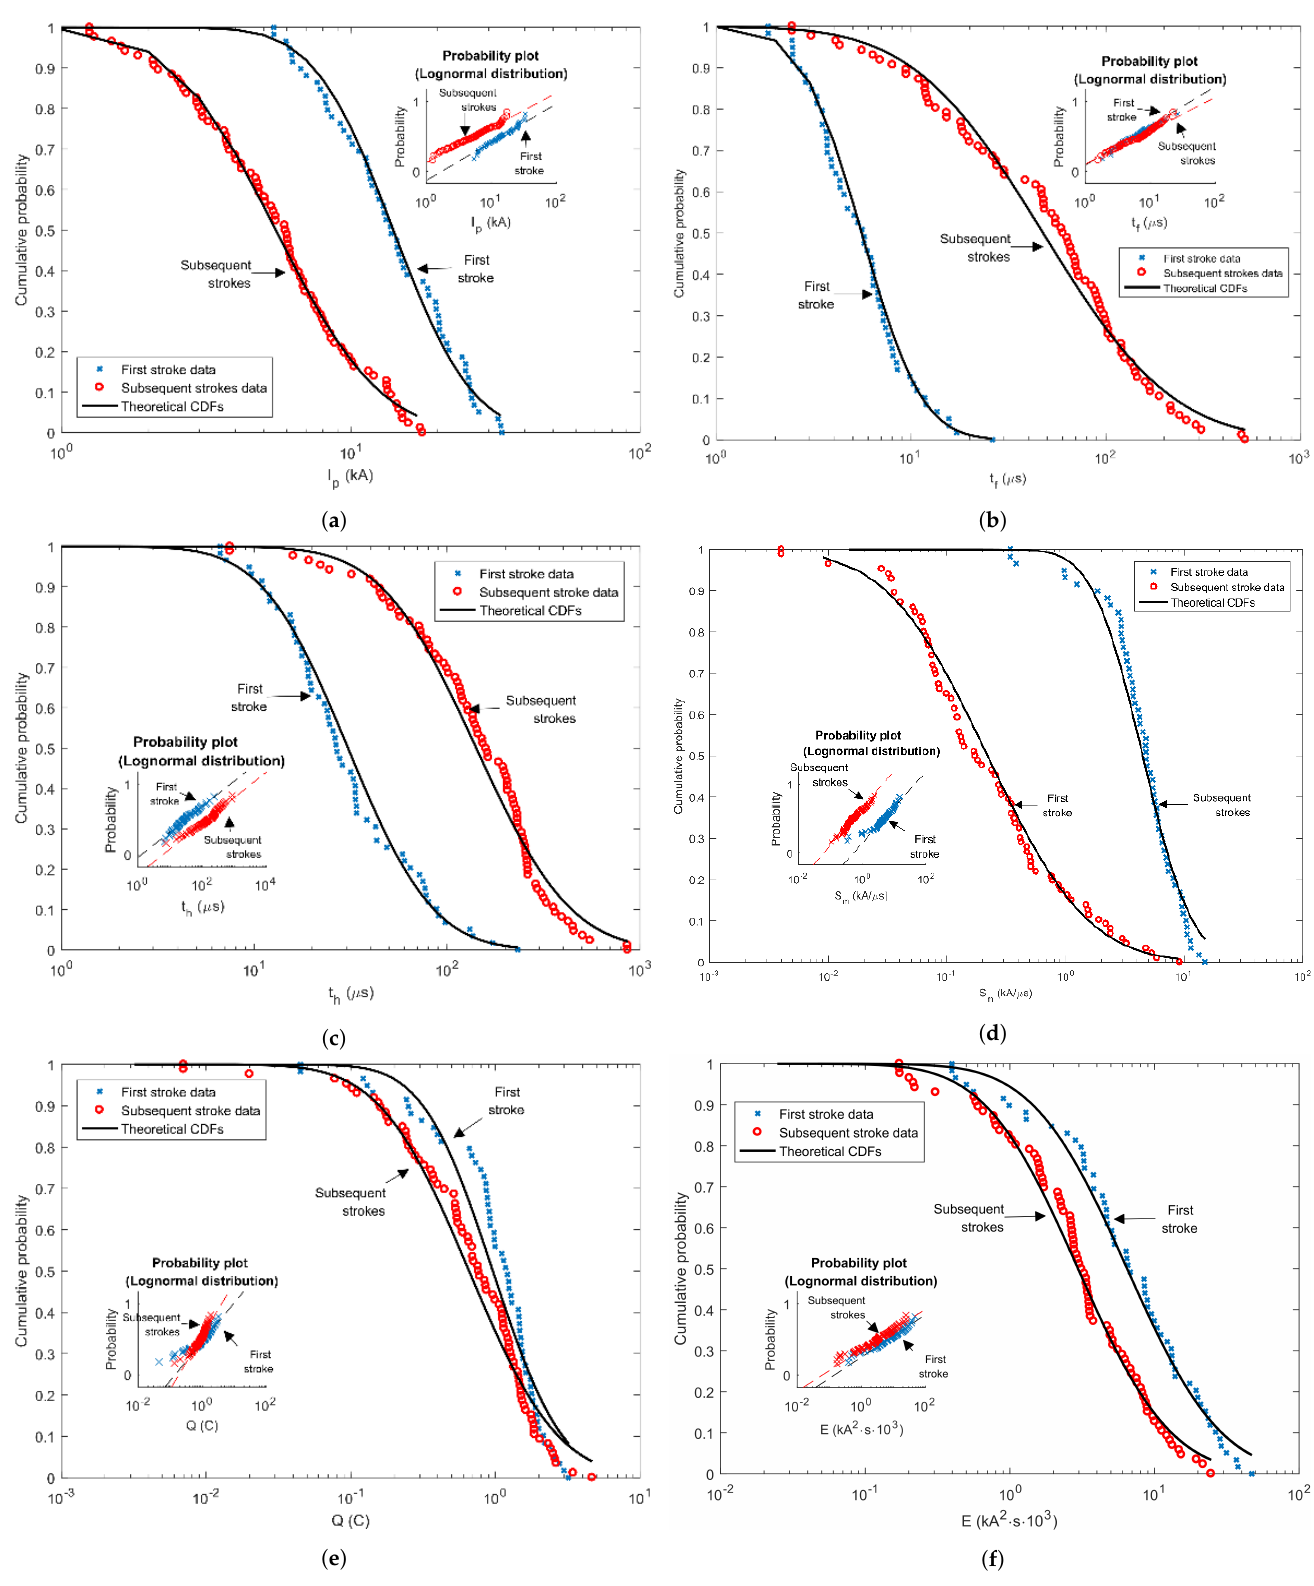
Figure 8. Cumulative statistical distributions of first and subsequent negative stroke currents − measured data and theoretical CDFs: ( a ) Peak stroke currents, ( b ) Front times, ( c ) Tail times, ( d ) Maximum steepness, ( e ) Stroke charges, ( f ) Specific